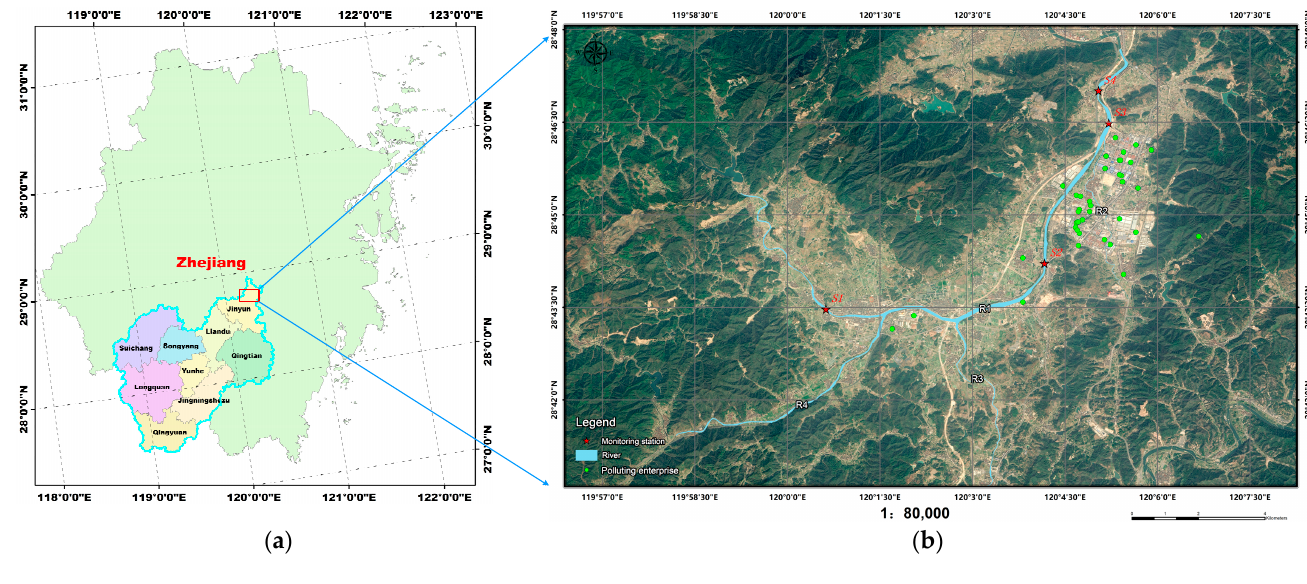
Figure 1. The location of the study area. ( a ) Study area in Lishui, Zhejiang Province, China; ( b ) The location of the study area and the water quality monitoring sites. Site 1: Xinjian Town water source; Site 2: Zhaiji; Site 3: Xiaxiaoxixia; Site 4: Guangyao. R1: Xinjian River; R2: Qiaoxi River; R3: Qianyangxi River; R4: Xinanxi River.